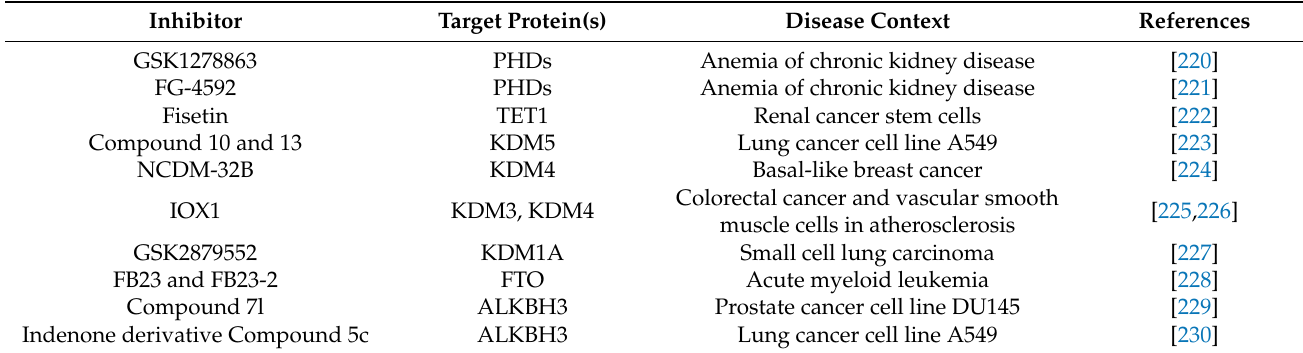
Table 1. Inhibitors of 2-OG